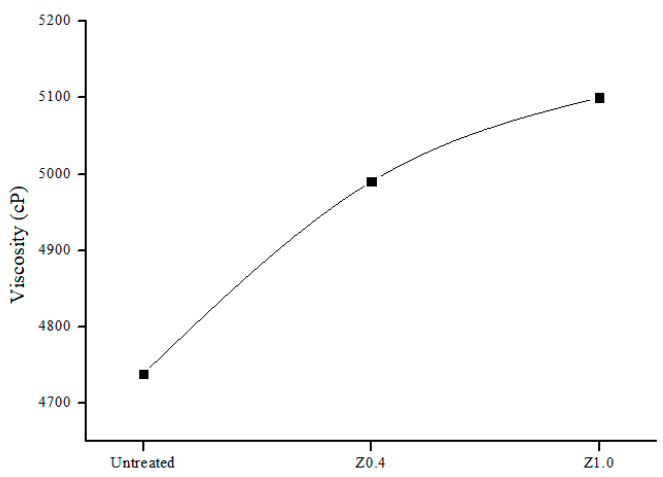
Figure 3. A plot of viscosity according to different loading of ZIF-8.